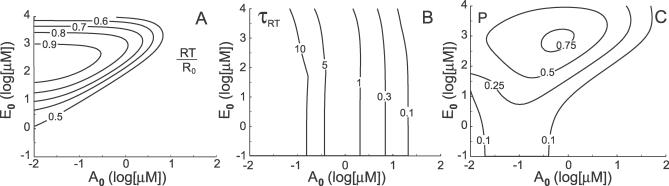
Concentrations of GEF and GAP Define the Efficiency of the GTPase CyclingThe profiles of the GTPase activity (A), recovery time (B), and performance index (C) are plotted as contour lines. While activity remains largely a function of the GEF concentration, the recovery time is determined mostly by the GAP concentration. Performance maximum with the activity 85% and recovery time ∼3 min is attained at E
0 = 0.78 mM and A
0 = 0.66 μM. Further increase in the turnover rate can be achieved at the expense of activity. Numbers on the contour lines indicate the levels of the respective characteristics. Total GTPase concentration is R
0 = 1 mM.